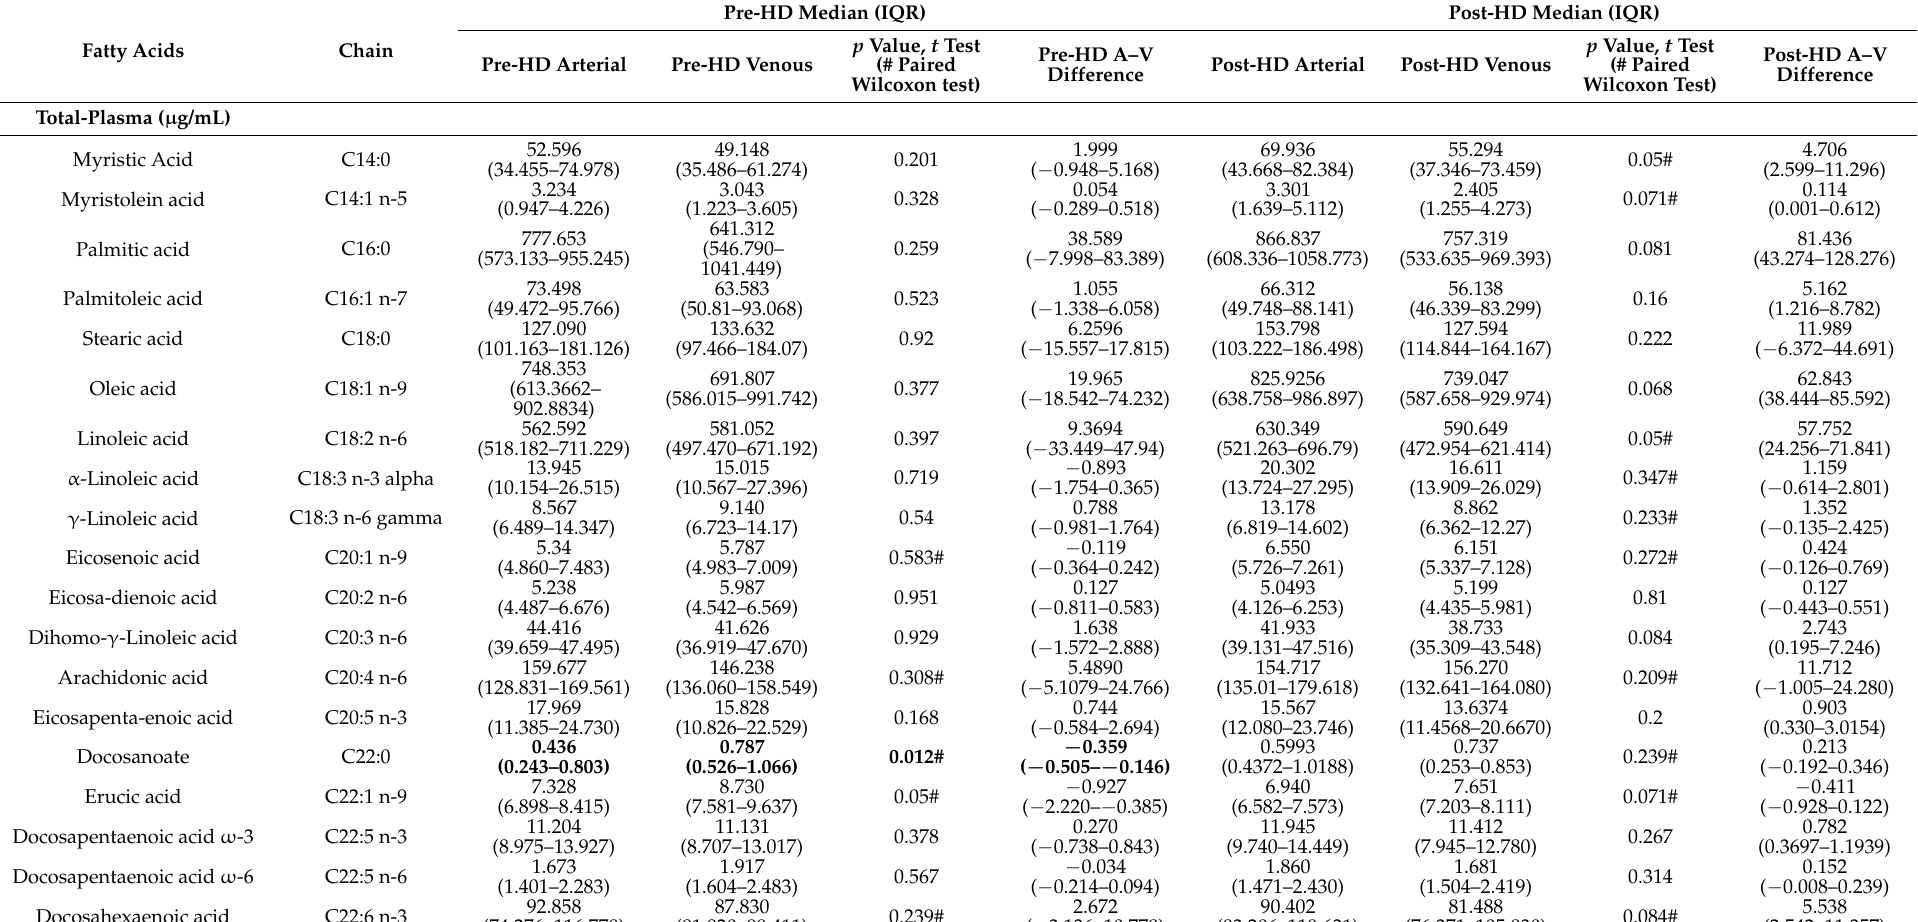
Table 2. Effects of hemodialysis on individual fatty acids in plasma and RBCs in the CKD patients before (pre-HD) and at cessation (post-HD) of hemodialysis ( n = 12